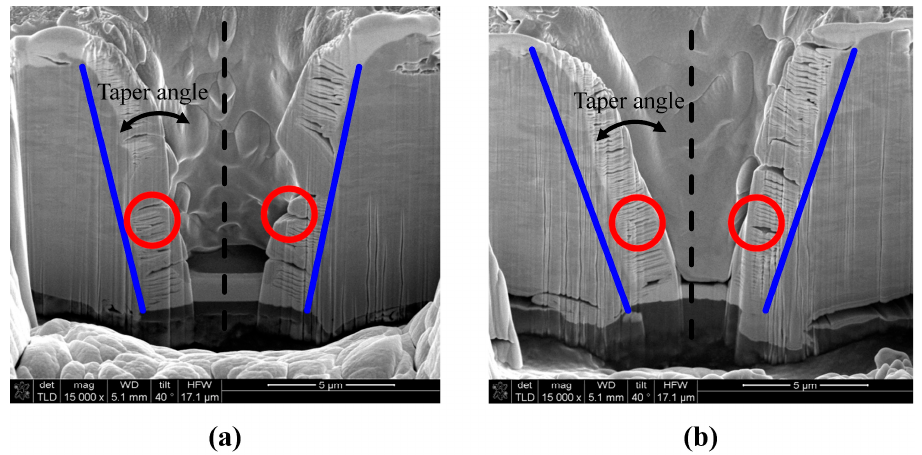
Figure 5. Examples of cross-sectional images of the hole drilled by vibration-assisted femtosecond laser drilling: Taper angles ( a ): 10.03°; ( b ): 14.22°; Experimental parameters: 1027 nm wavelength, 190 fs pulse duration, 1 kHz repetition rate, 1.1 μ J pulse energy, 100 pulses. Settings for M Plan Apo NIR (Mitutoyo): 0.42 NA, 50× lens magnification, 200 Hz of vibration frequency, vibration amplitudes ( a ): 1.4 μ m; ( b ): 3.1 μ m.